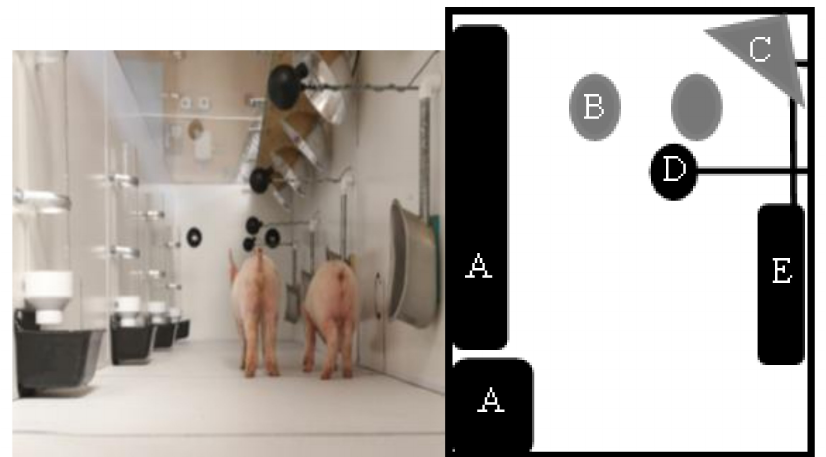
Figure 2. Image on the left displays of one thermal apparatus with a group of 2 piglets. On the right, a diagram depicts what was inside the thermal apparatus: (A) feeders with PVC pipe to allow gravity feeding found within each thermal zone (0.40 m apart), (B) two computer fans that ducted cold air into the thermal apparatus located 0.60 m from the ground, (C) heating elements inside a heat guard, (D) 3” black globe with data logger probe measuring temperature every 15 min located in the middle of each thermal zone 0.40 m apart, and (E) waterers with ad libitum access located 0.40 m apart and within each thermal zone. A total of 5 feeders, waterers and black globes, one per thermal zone, were within each